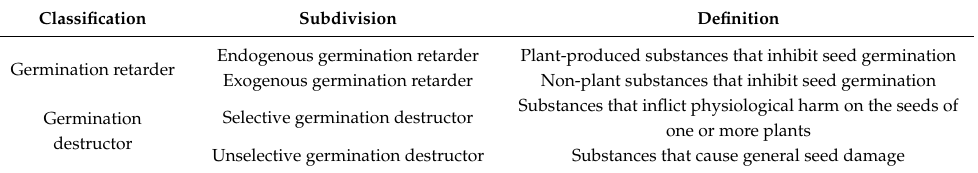
Table 1. Classification of germination inhibitors by function.